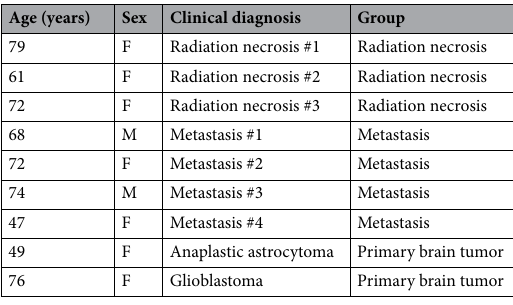
Table 1. Patient